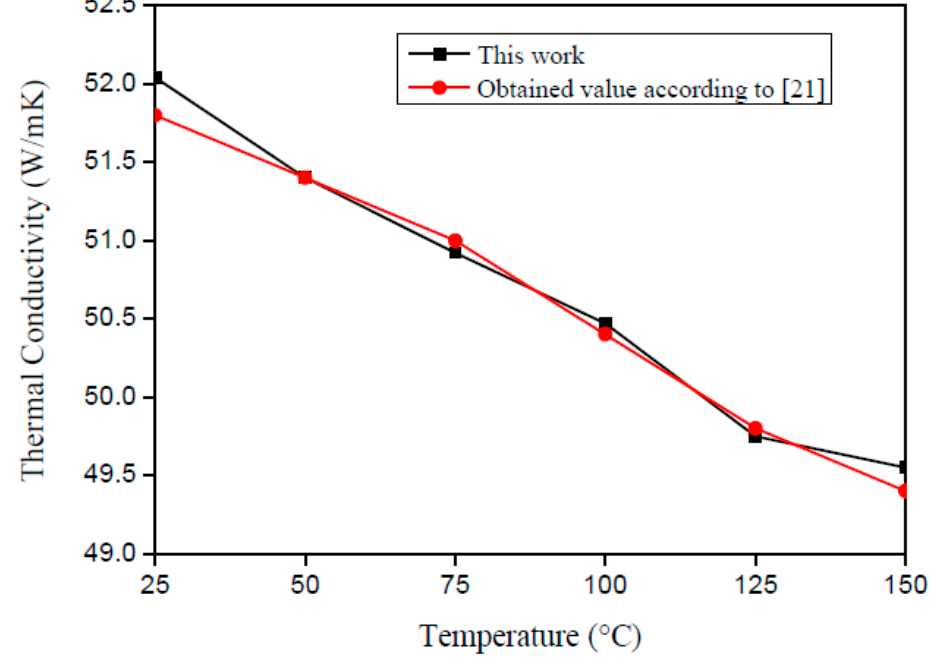
Figure 9. Comparison between the literature values with the estimated results of λ on the AISI 1045 steel sample.